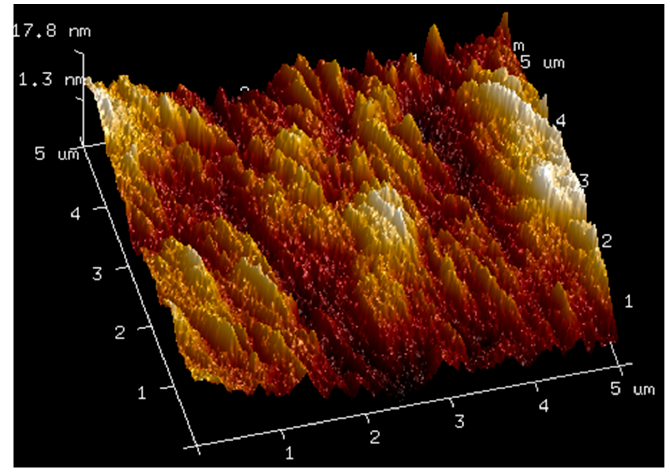
Figure 5. AFM visualization of the surface of film obtained from the solution of 1.5% low-molecular HA.